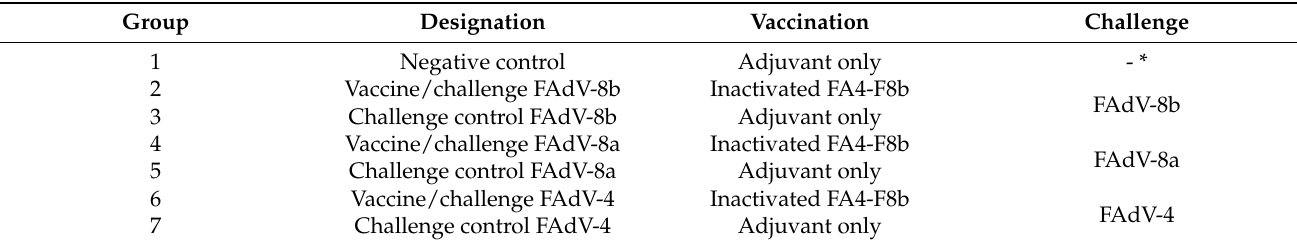
Table 3. Design of the animal